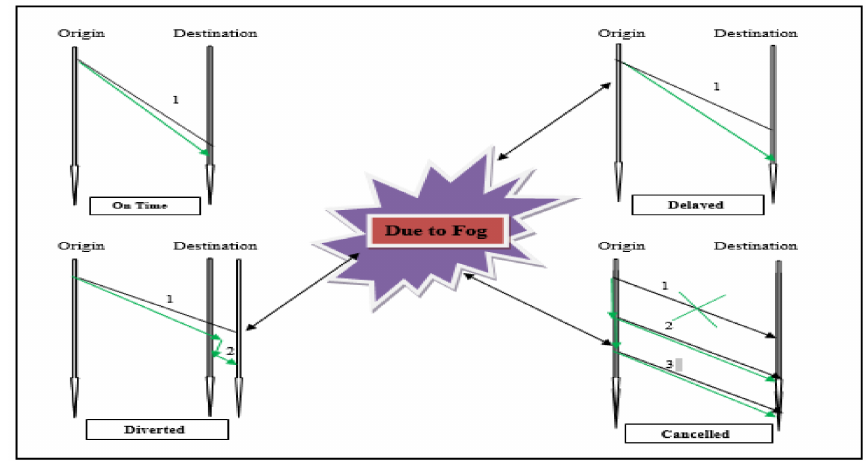
Figure 2. Schematic showing the possible e ff ects of fog on flight